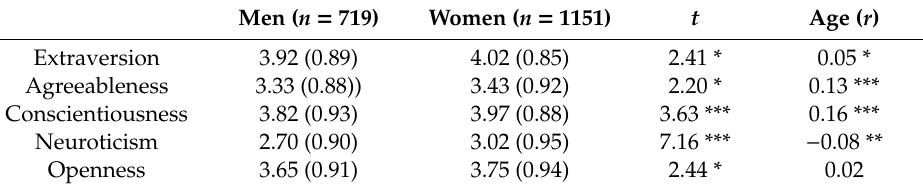
Table 1. Means (SD), t , correlations and p values for sex, age, and personality